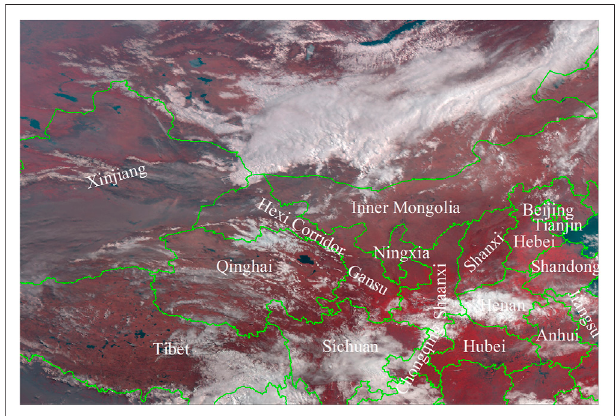
FIGURE 1 | Spatial distribution of clouds and dust storms derived from the Himawari-8 geostationary satellite at 09:00 BT on 11